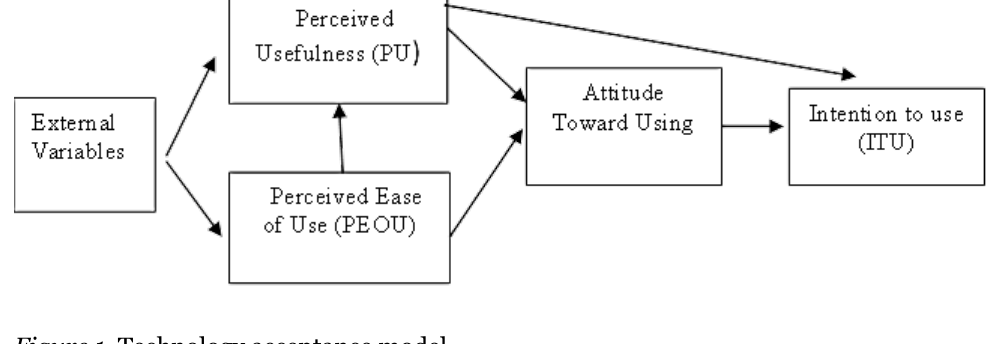
Figure 1. Technology acceptance